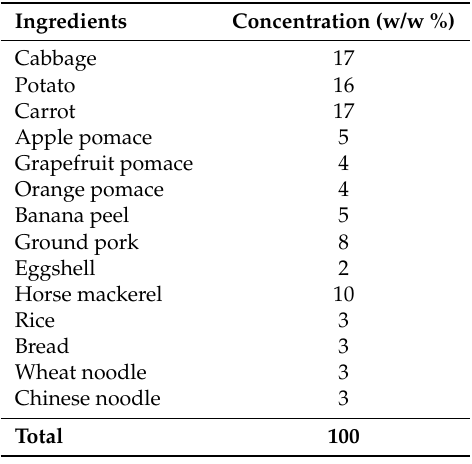
Table 1. Ingredients in the experimental household waste.